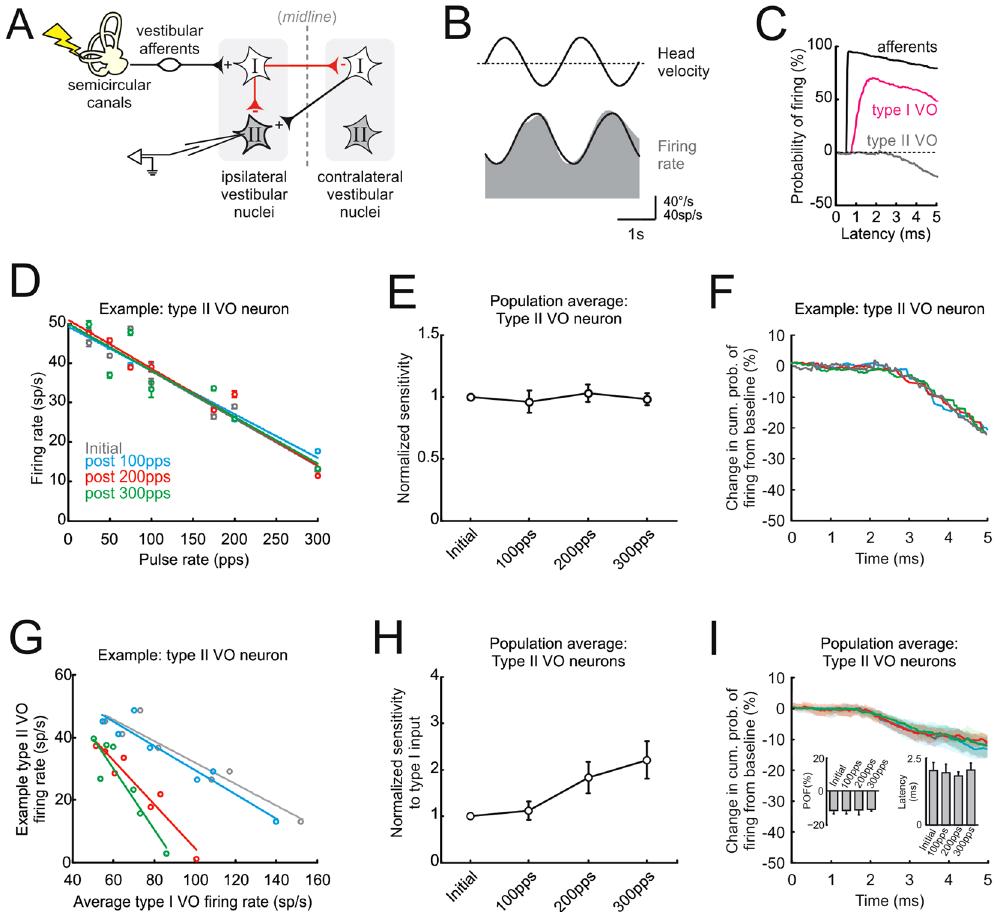
Figure 5. Inhibitory vestibular nuclei pathways display rapid compensatory plasticity. ( A ) Diagram of possible inhibitory pathways linking ipsilateral vestibular nerve and type II VO neurons. ( B ) Example type II VO neuron increases its firing as a function of contralateral head velocity. ( C ) While vestibular afferents are activated almost immediately and type I VO neurons at monosynaptic latencies, type II VO neurons show a decrease in probability of firing with a latency consistent with their response being mediated by polysynaptic pathways. ( D ) Firing rate as a function of pulse rate for example type II neuron before and after activation of the vestibular nerve. ( E ) Normalized sensitivity for the population of type II VO neurons. ( F ) Change in cumulative probability of firing from baseline as a function of time from onset of individual pulses for example neuron. ( G ) Firing rate of example type II VO neuron as a function of averaged type I VO neuron firing rate. ( H ) Normalized sensitivity of type II VO neurons relative to type I VO neuron input. ( I ) Change in cumulative probability of firing from baseline as a function of time from onset of individual pulses for the population of type II neurons. Insets show probability of firing (POF) and latency calculated from the change in probability of firing from baseline curves for type II VO neurons. Error bars and shaded area represent ±